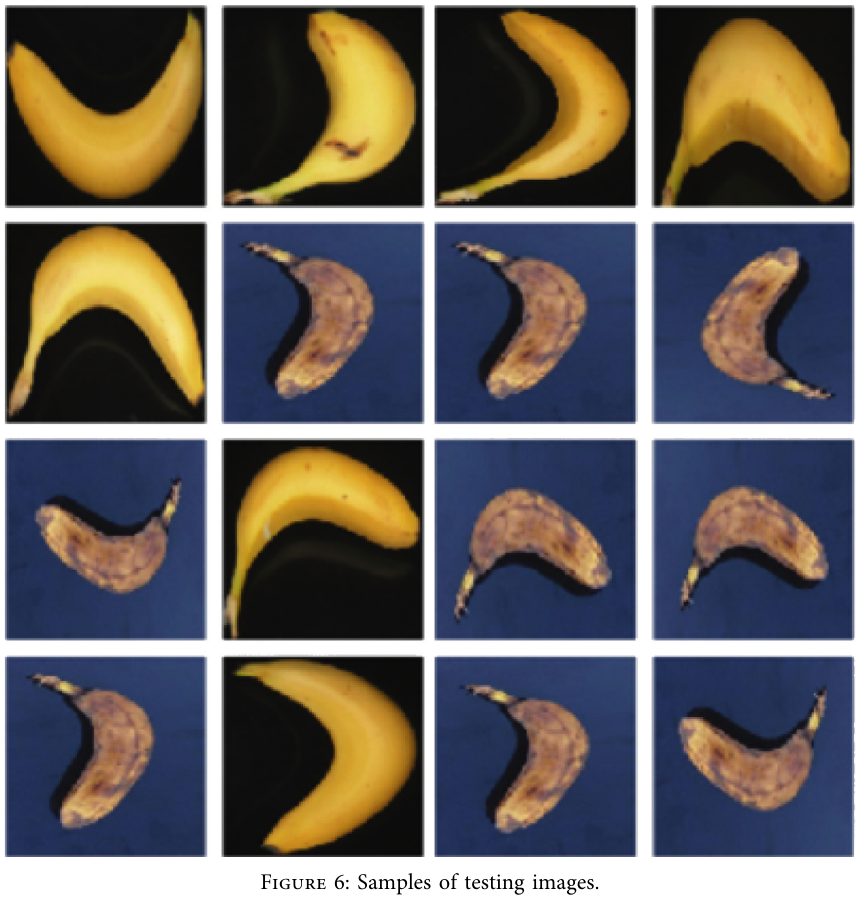
Figure 6: Samples of testing